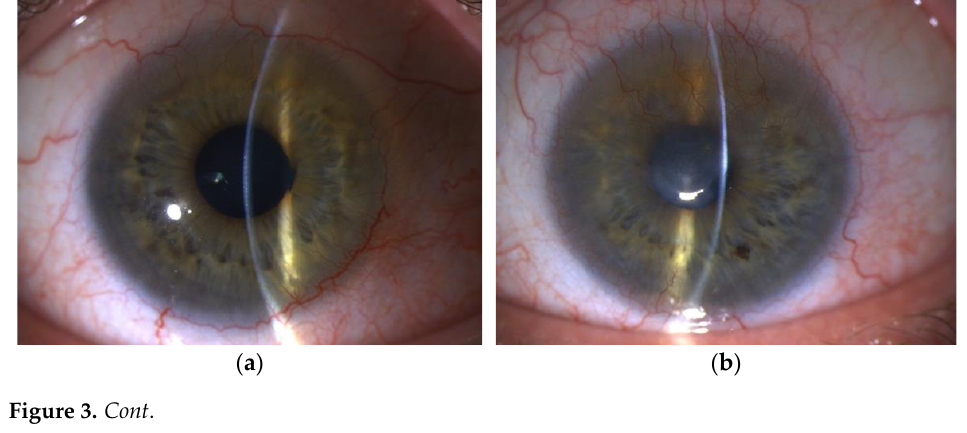
eye. 9 mm corneal pachymetry map. The final diagnosis is RE — total unilateral LSCD, persistent epithelial defect. Normal corneal thickness under the pannus. The patient was scheduled for G-SLET on that eye.